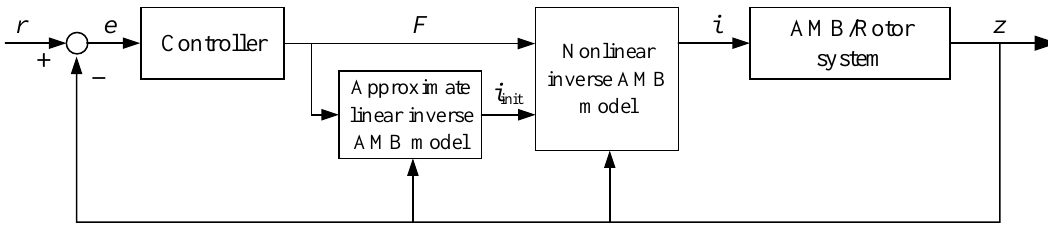
(b) Figure 7. Feedback control scheme for exact